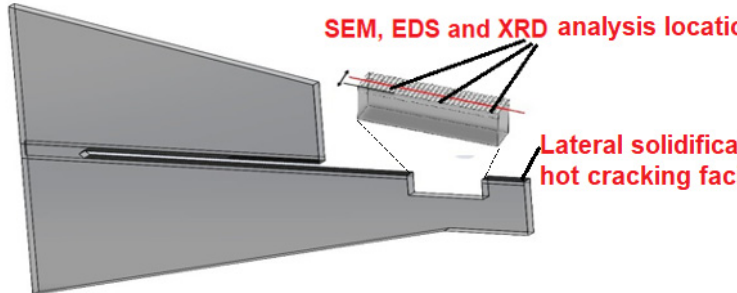
Figure 3. Liquid penetrant kit used after welding ( a ) on the weld line ( b ).